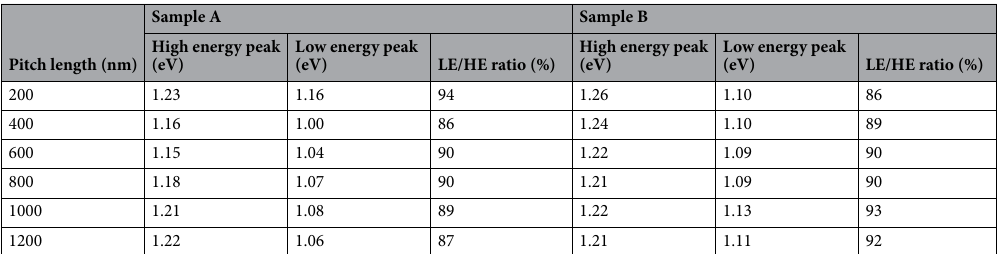
Table 2. Summary of patterned 4 K spectral response